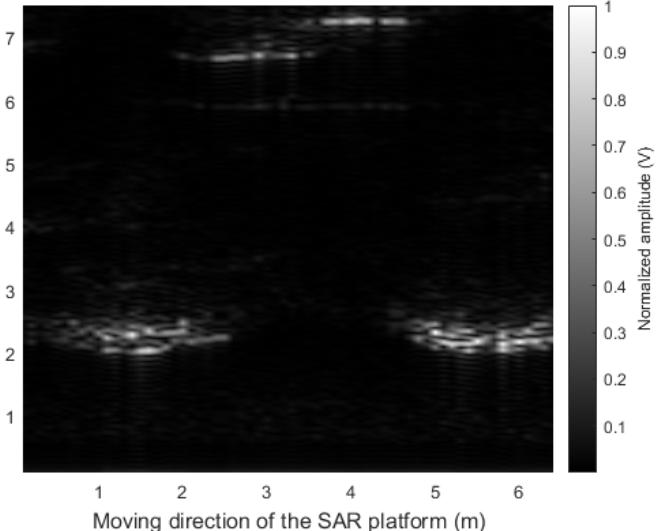
Figure 9. SAR image reconstruction result using the sensor data acquired from all measurement points (i.e., using the conventional RMA